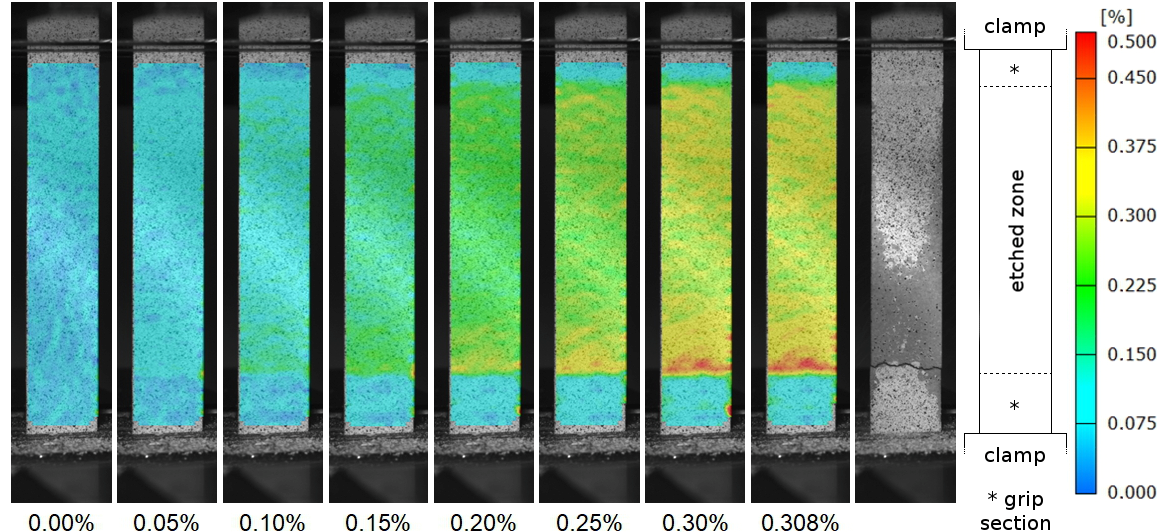
Figure 9. Strain distribution of specimen 5 measured by optical strain analysis. The nine subpictures show the states at the given total strain (values under the pictures) and, for the last, after the fracture. Values on the right side (color scale) show the local strain. The illustration on the right side shows in detail to the last two subpictures the exact position of the clamps and the transitions between etched zone and grip sections.